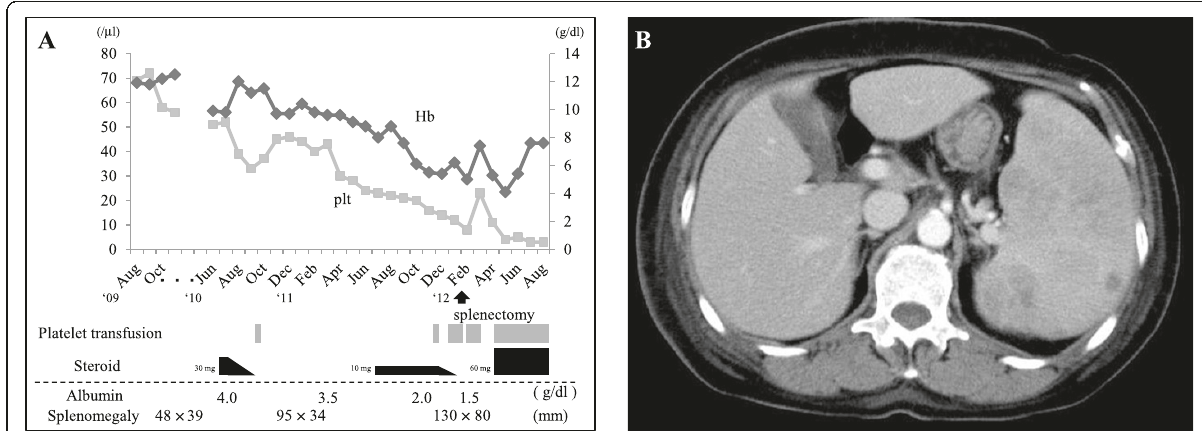
Figure 1 Summary of various clinical data before and after splenectomy, and the finding of an abdominal CT scan at surgery. ( A ) This patient showed prolonged idiopathic thrombocytopenia presenting with increased splenomegaly and non-response to steroid therapy. In addition, progressive pancytopenia, hypo-albuminemia, and hypo- γ -globulinemia coexisted. ( B ) The abdominal CT scanning revealed heterogeneously enhanced, severe splenomegaly without evidence of mass or nodular